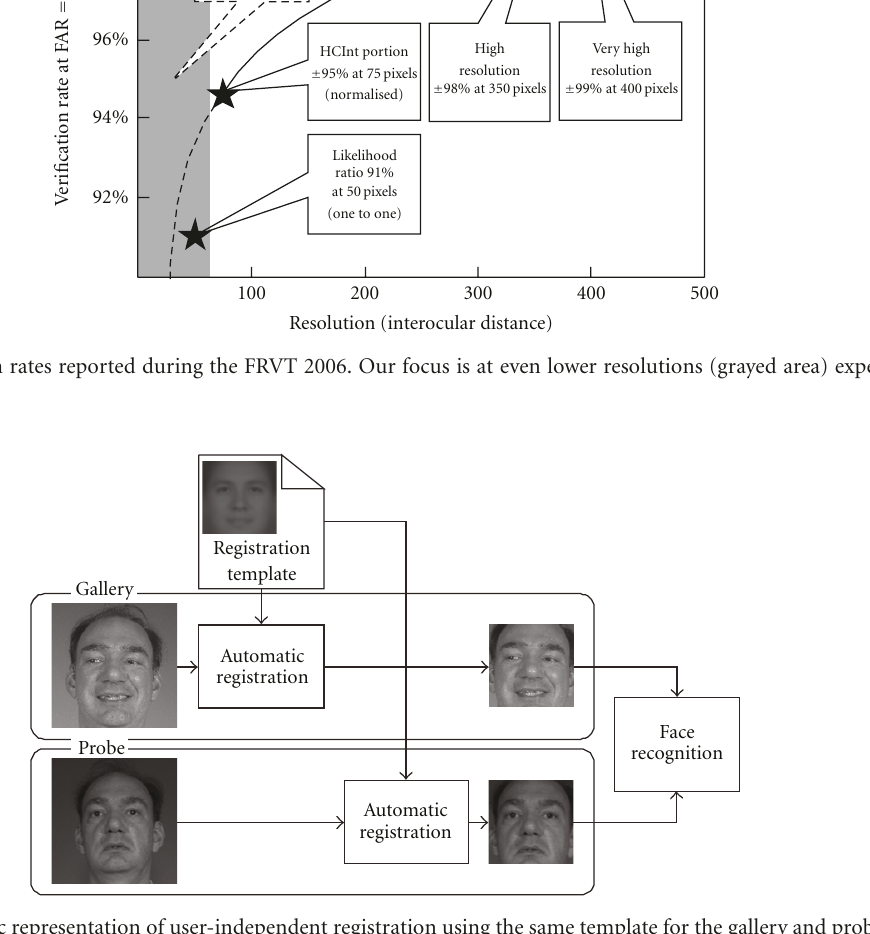
Figure 4: Schematic representation of user-independent registration using the same template for the gallery and probe